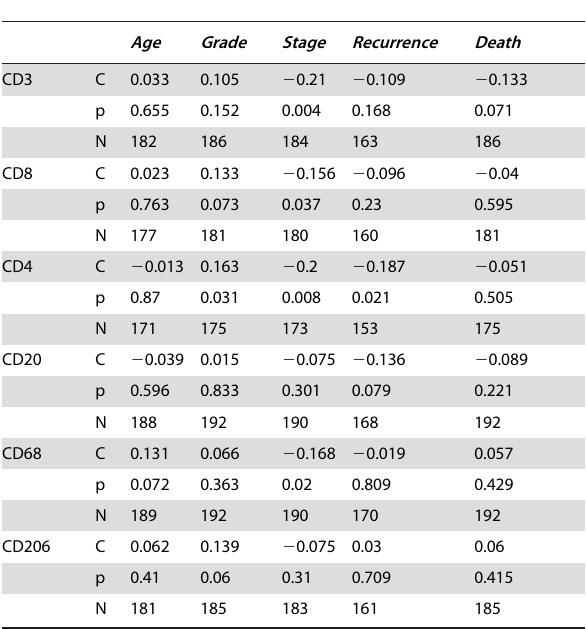
Table showing the coefficient of correlation with a Pearson correlation test (Pearson Correlation) between clinical parameters and immune infiltrate density in the intra-epithelial ovarian tumor tissues. Grade and stage were evaluated according to the FIGO classification. Res. Dis.= amount of residual disease at primary resection of the tumor as described in Table 1. Recurrence is the first event of ovarian cancer recurrence after the primary resection of the tumor. Death is the event of death due to ovarian cancer. CA125= blood serum level CA125 at the date of primary resection of the ovarian tumor. P is the p value from Pearson correlation test. N is the number of cases included in the statistical analysis. C= Pearson correlation coefficient. P=p value. N= number of cases.